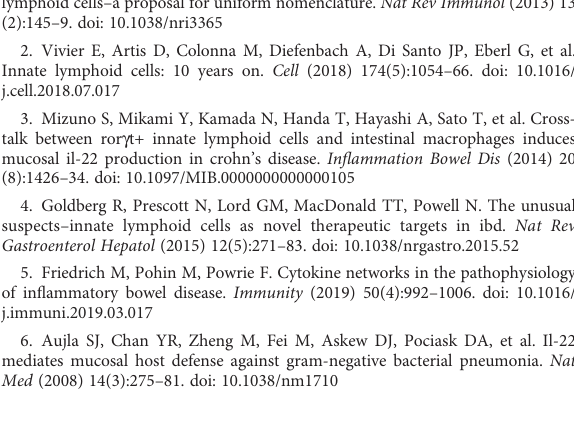
SUPPLEMENTARY FIGURE 2 (A) Representative fl ow cytometry plots of cytokine production by ILC2s in the control and DSS-treated groups stimulated with PMA plus ionomycin. (B) Frequency of IL-5 and IL-13 producing colonic ILC2s in each group among all ILC2s. Graphs show pooled data from three independent experiments (n=12 for each group). (C) Frequencies of IL-5 producing colonic ILC2s among all ILC2s of each group stimulated with PMA plus ionomycin, IL-25, IL-33, and IL-25 plus IL-33 for 4h (n=4 for each group). (D) Gating strategy for the enrichment of colonic ILC2s. (E) Heatmap showing the relative expression of signature genes of ILC2s (22) and the number of upregulated (12 genes) and downregulated genes (20 genes) in DSS-treated mice compared to that in control mice (n=3 for each group). (F) TPM values of signature genes of ILC2s and other groups of ILCs. *P<0.05, **P<0.01, ***P<0.001. SUPPLEMENTARY FIGURE 3 Rag2 -de fi cient mice were injected anti IFNAR1 antibody i.p. on day 0 and administered DSS (n=4 for control group and n=5 for anti IFNAR1 i.p. injectedgroup). (A) Changein%bodyweightrelativetoinitialbodyweight of control mice (DSS treated) (n=4) and anti IFNAR1 i.p. injected mice (DSS treated) (n=5). (B) Disease activity index (DAI) score on day 7 and colon length of the mice in each group. (C, D) Histological score and histopathology of the distal colon. (E) Frequency of AREG expressing ILC2s among all ILC2s in each group. (F) The number of colonic ILC2s, eosinophil,andmastcellsincontrolandDSS-treated Rag2 -de fi cientmice (n=3 for each group). (G) Frequency of AREG expressing ILC2s among all ILC2s following 4h in vitro stimulation with or without IFN b . 12 mice were used and 2 mice were pooled in one sample. n=3 for each group. (H) FPKM (fragments per kilobase million) values of Il5, Areg, and Stat2 of ILC2s treated with IL-33 or IL-33 plus IFN- g . Data are mean and SEM. SUPPLEMENTARY FIGURE 4 (A) Representative contour plots showing IRF7 expressing ILC2s in control mice (DSS treated), anti IFNAR1 i.p. injected mice (DSS treated), and anti IFNAR1 plus rAREG i.p. injected mice (DSS treated). (B) MFI of IRF7 in ILC2s (n=4 per group from one experiment). (C) Absolute number of IRF7 + ILC2s in each group. Graphs show pooled data from two independent experiments (n=6 for control mice, n=8 for anti IFNAR1 i.p. injected mice and anti IFNAR1 plus rAREG i.p. injected mice). Data are mean and